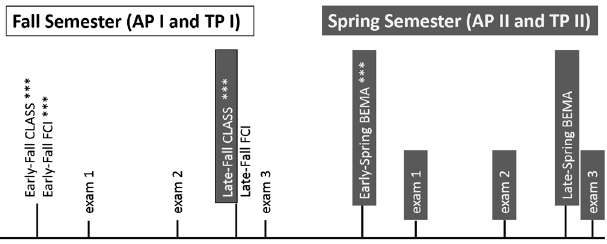
FIG. 5. Summary timeline of study procedures. Measures with dark font and no background are part of the analysis of fall semester courses (AP I and TP I). Measures with white font and dark background are part of analysis of spring semester courses (AP II an TP II). Measures followed by *** are predictor variables and other measures are dependent